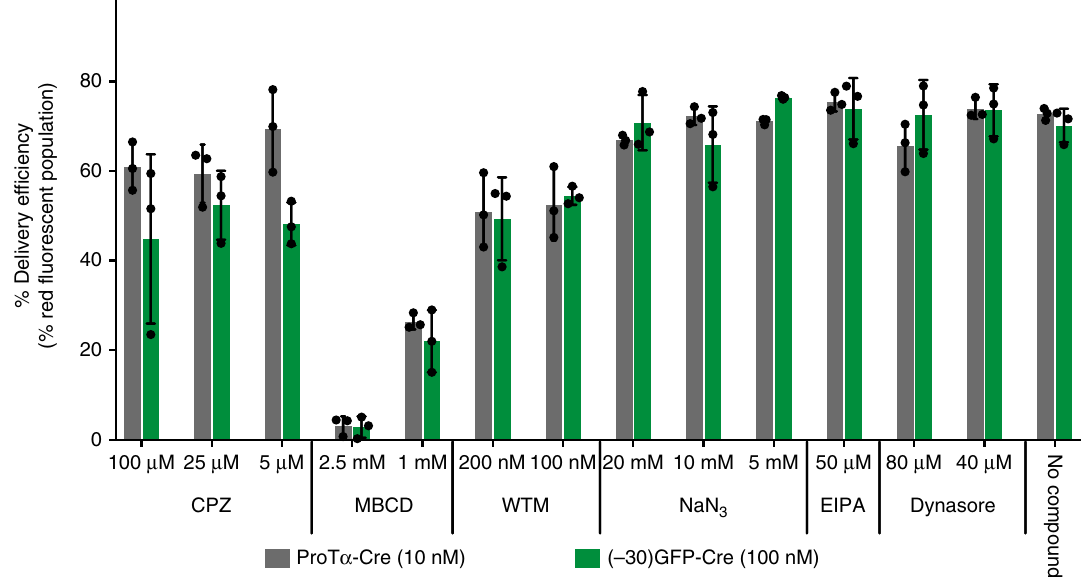
Fig. 4 Effect of various endocytosis inhibitors on ProT α - and ( – 30)GFP-mediated lipid nanoparticle delivery. Cationic lipid nanoparticles combined with either 10 nM ProT α -Cre or 100 nM ( – 30)GFP-Cre were incubated with HEK293-RFP cells that had been pre-treated with inhibitors that block various endocytosis pathways. After 2 day, delivery ef fi ciency was measured via fl ow cytometry, and the percent of cells containing red fl uorescence was quanti fi ed and normalized against a control sample lacking any inhibitor. Chloropramazine (CPZ) and wortmannin (WTM) modestly decreased the delivery ef fi ciency, whereas MBCD strongly blocked Cre recombination. Values and error bars represent the mean and standard deviation of three independent biological replicates performed on different days. Source data are available in the Source Data fi le